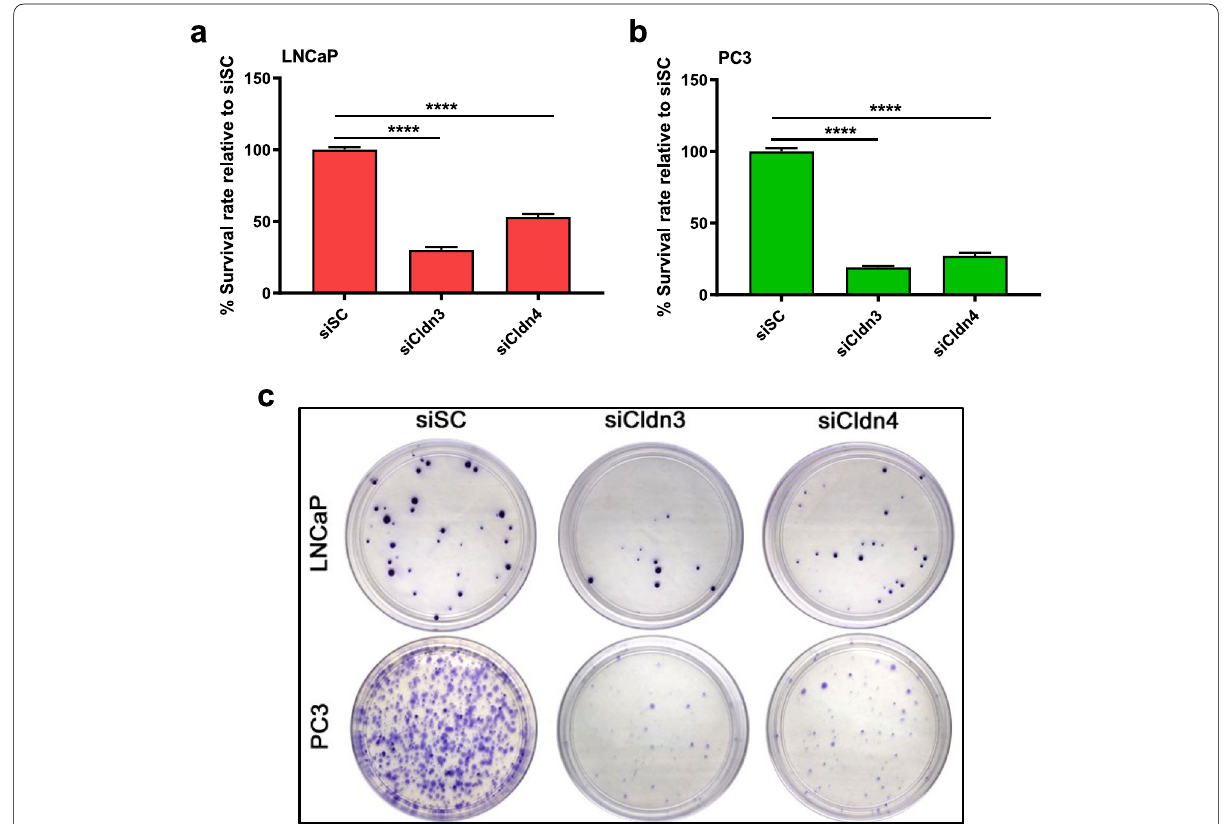
Fig. 5 Clonogenic survival upon siCldn treatment. Treatment with siCldn3 and siCldn4 was performed on human prostate cancer ( a ) LNCaP and ( b ) PC3 cells. c Crystal violet staining was performed to visualize colony formation. Data are shown as mean where **** represents p <